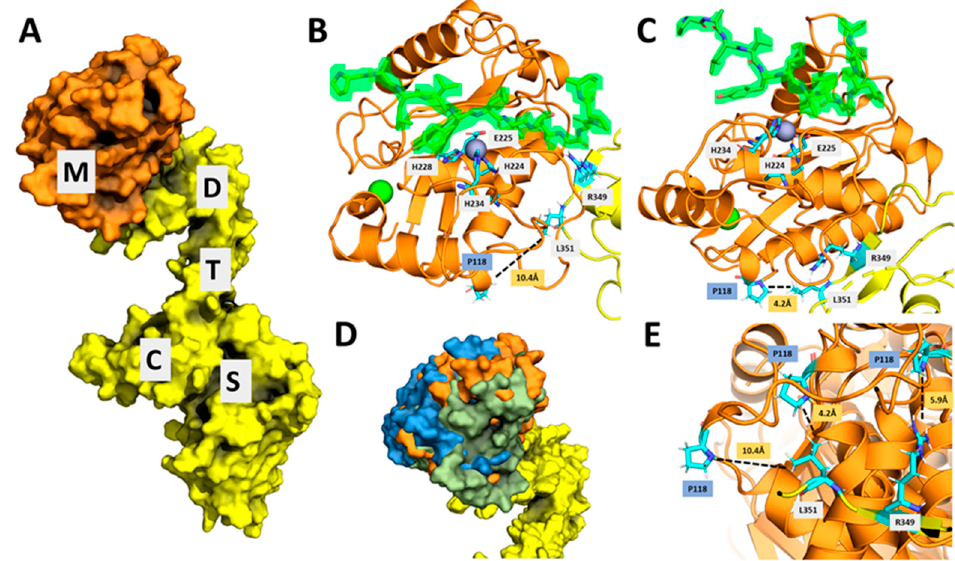
Figure 5. Predicted interactions of homology model of metalloprotease (M) domain and crystal structure of DTCS (Crystal structure of Disintegrin (D), TSR Repeat-1 (T), Cysteine-rich (C), and Spacer (S) domains of ADAMTS13) domains. ( A ) A top-scoring model of the metalloprotease (M, orange) docked (using Rosetta Dock Protocol) onto the DTCS domains (yellow) from ADAMTS13. ( B ) Model showing the active site of the metalloprotease including the Zn ion (grey sphere), Ca ion (green sphere), active site residues (H228, H224, H234, E225), synonymous variant p. P118P, VWF A2 cleavage peptide PALVYMVTGNPA (green highlight), and previously reported important residues in the D domain (L351, R349). Distance between P118 and D domain residues (dotted line) is measured throughout to demonstrate the movement of possible di ff erent conformational states as the metalloprotease domain interaction with the D domain changes upon previously demonstrated allosteric. ( C ) Another top-scoring model shows that the metalloprotease is in a di ff erent conformation relative to the D domain, changing the distance between the P118 and the L351. ( D ) Three top-scoring models (blue, orange, and green) aligned on top of each other show the di ff erent conformational space the metalloprotease can be docked relative to D domain. ( E ) The three top-scoring models (same as D) are aligned and shown with the di ff erent distances between P118 and the L351 and R349 residues on the D domain.